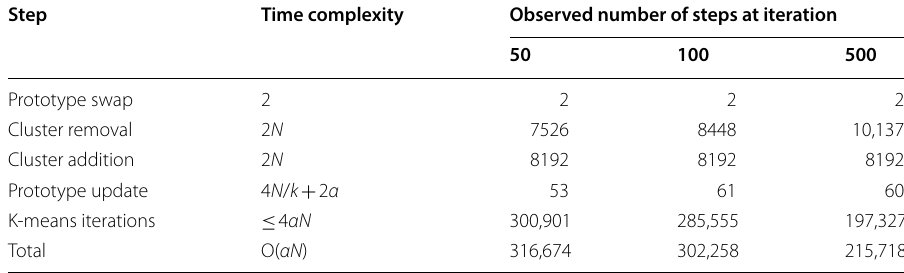
Table 1 Time complexity estimations of the steps of the random swap algorithm, and the observed numbers as the averages over the first 500 iterations for data set Bridge (N 4096, k 256, N/k 16, α 8) = = = ≈